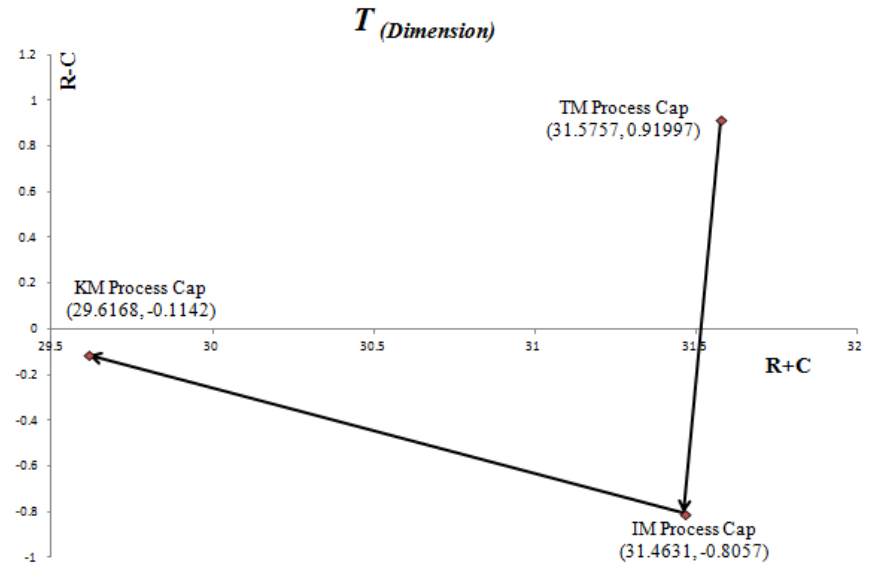
Figure 10. The IRM of dimensions.